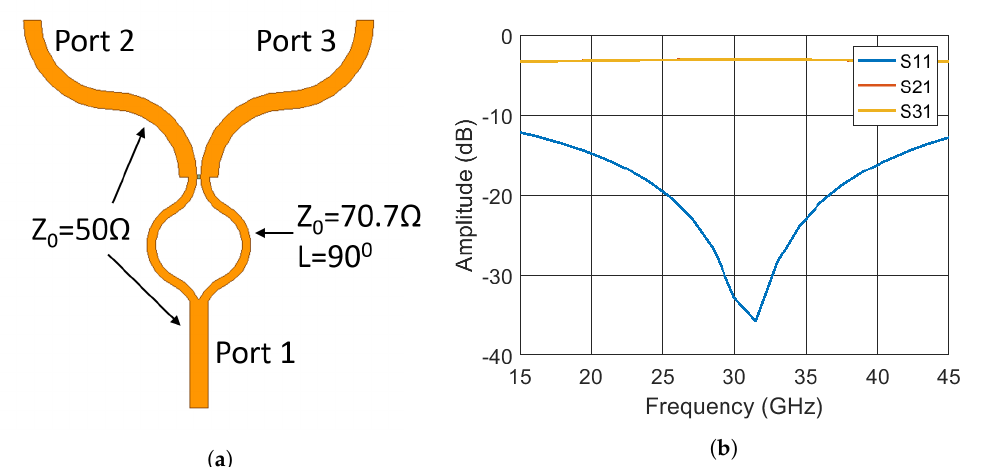
Figure 28. Equal power Wilkinson power divider: ( a ) layout of the equal power split Wilkinson power divider; and ( b ) amplitude response of the equal power split Wilkinson power